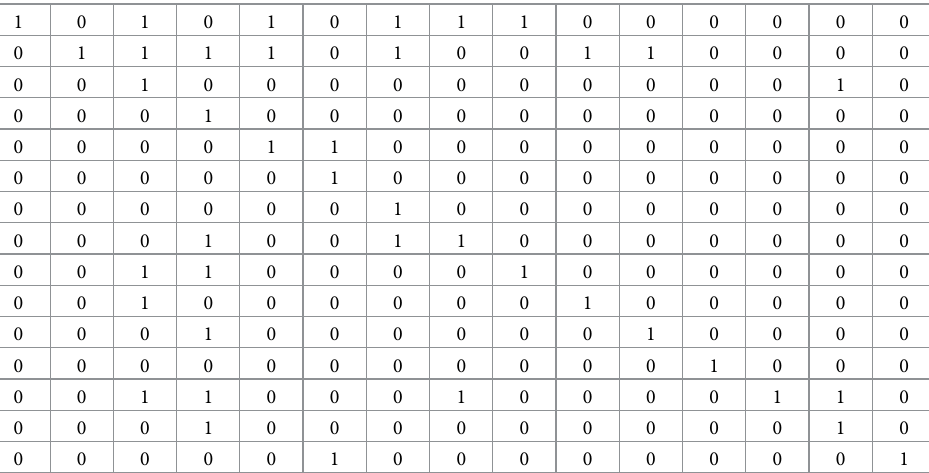
Table 6. Reachability